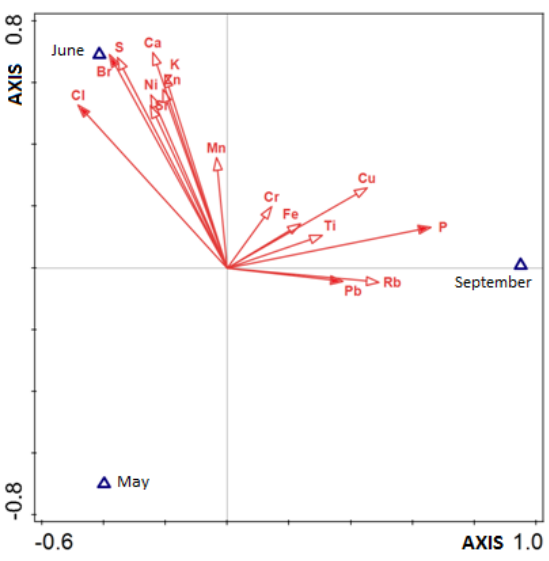
Figure 6: Discriminant analysis (CVA) of data on changes in the content of elements in the studied months (May, June and September). Elements, which significantly differentiate the test set indicates full returns vectors. It explain together 75.5 % of the total variability of